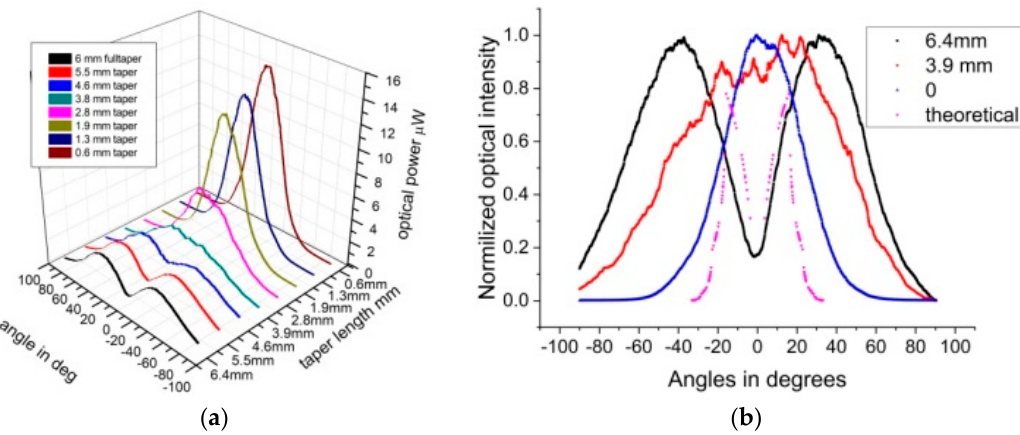
Figure 13. ( a ) Angular intensity distributions for cutbacks full taper 6.4 mm, ( b ) Normalized angular